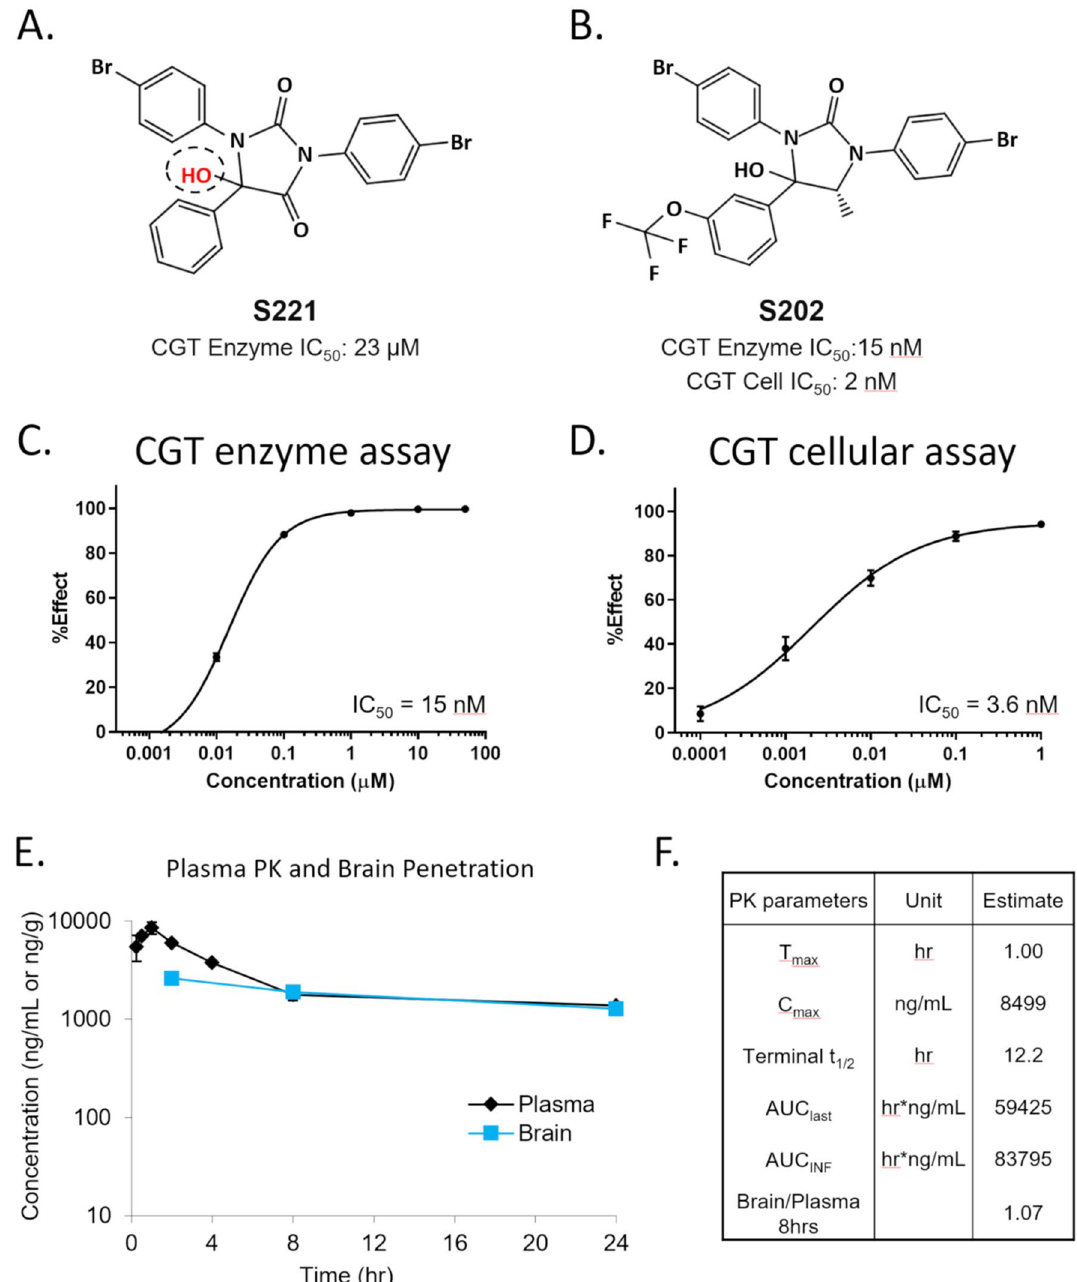
Figure 2. Identification of a novel potent and brain penetrant CGT inhibitor. S221 was identified in a screen of a focused bioactive lipid library ( A ). S221 was determined to be an oxidation product of (CAY10508), which had acquired a hydroxyl group (in red) on the central ring. Through a medicinal chemistry effort S202 was discovered as a more potent CGT inhibitor ( B ) showing a 400-fold increased potency in a CGT enzyme assay ( C ) and single digit nanomolar potency in a CGT cellular assay ( D ) (n = 2 per concentration). Mouse pharmacokinetic (PK) and brain concentration profile graph (n = 3, E ) and PK parameter table ( F ) for S202 after a single IP injection show favorable in vivo half-life and brain penetration